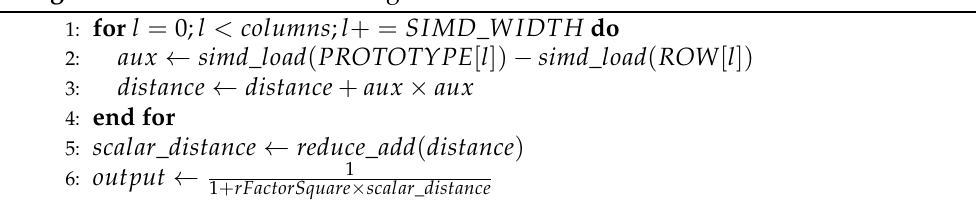
Algorithm 8: SIMD version of Algorithm 5 line 5.